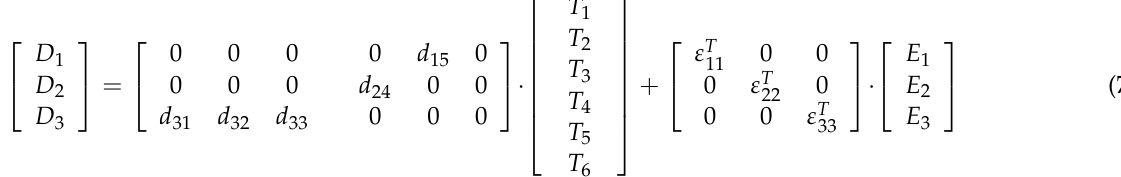
Table 1. LDT1-028K film characteristics [36].